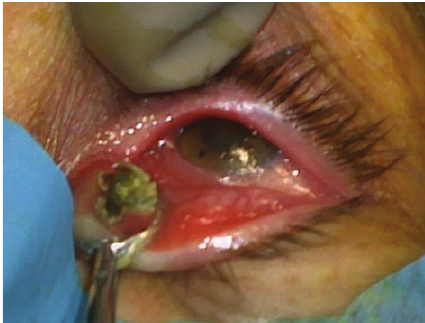
Figure 1: The incision perpendicularly revealed the content of the abscess.